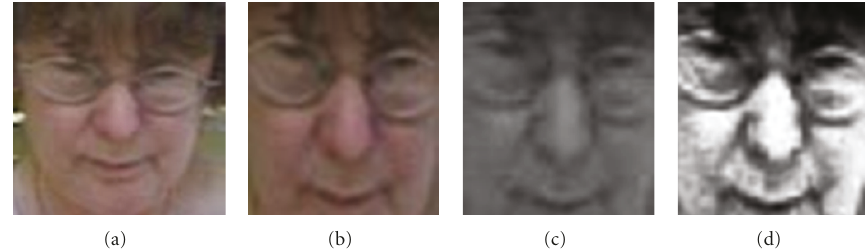
Figure 3: Preprocessing face images. (a) Detected face. (b) Cropped face (inner face). (c) Grayscale face. (d) Histogram-equalized face.